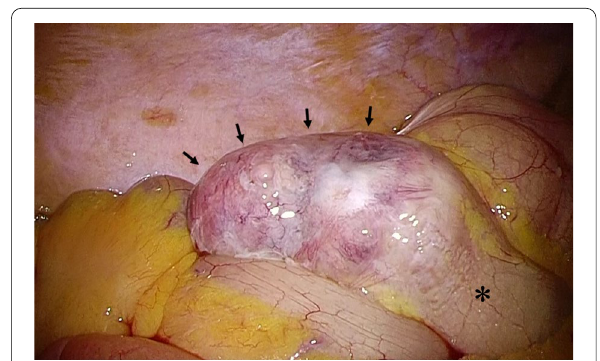
Fig. 3 Intraoperative findings of the appendix. The appendix (black arrows) was dilated, and the border with the cecum (*) was